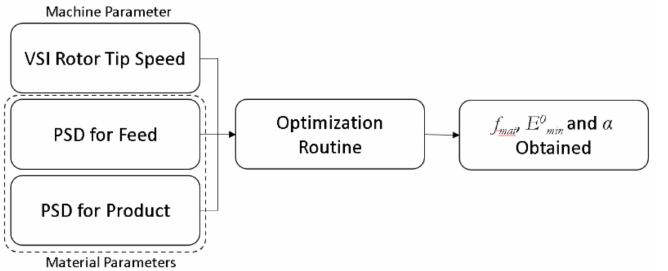
Figure 3. The overall modelling process for a new site where the material has not been calibrated and then adequately mapped to the material